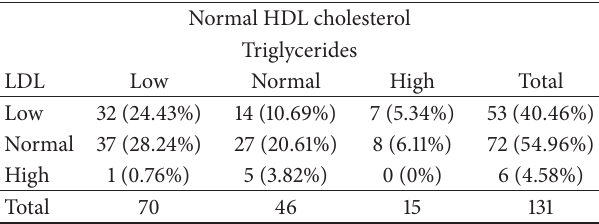
Table 4: Distribution of dyslipidemia in patients with a normal level of HDL cholesterol.